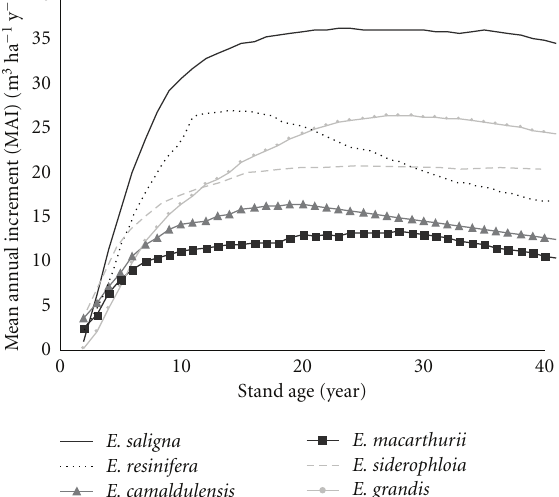
Figure 6: Mean annual increment (MAI) of the six Eucalyptus species analysed in the Tchianga